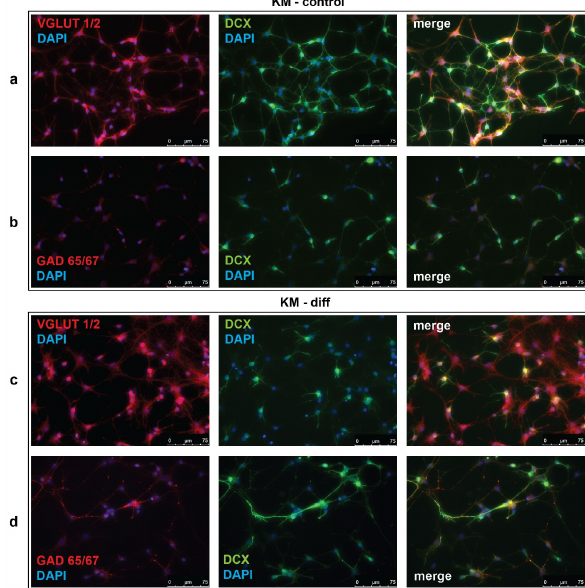
Figure 1. Immunofluorescent analysis of vesicular glutamate transporter 1 and 2 (VGLUT1/2), glutamate decarboxylase 65 and 67 (GAD65/67), and doublecortin (DCX) in cultured neural progenitor cells (NPC) isolated from Krushinsky–Molodkina (KM) rat embryos. ( a , c ) NPC of KM rats were stained for VGLUT1/2 (red) or ( b , d ) GAD65/67 (red) in combination with DCX (green) in control (KM-control) and neurotrophin-stimulated cultures (KM-diff). Cell nuclei were stained by 4’,6-diamino-2-phenylindole (DAPI) (blue). Merged images demonstrate cells with co-localization of VGLUT1/2 or GAD65/67 with DCX. Data are representative of three independent experiments.